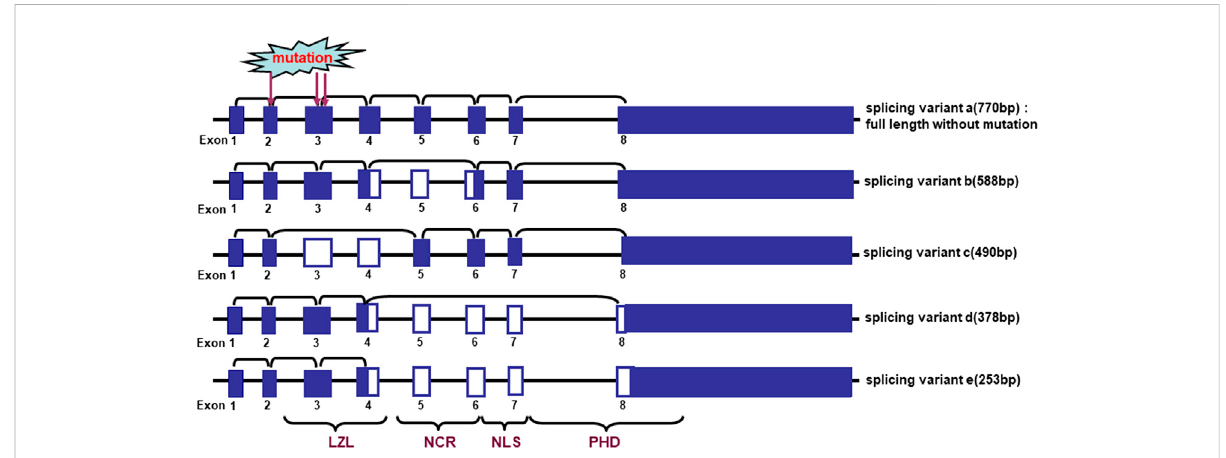
FIGURE 3 Alternative splicing of ING5 mRNA in oral squamous cell carcinoma. The schematic representation indicates the genomic structure and alternatively splicing variants of ING5. LZL, leucine zipper-Like motif; NCR: novel conserved region; NLS, nuclear localization signal; PHD, plant